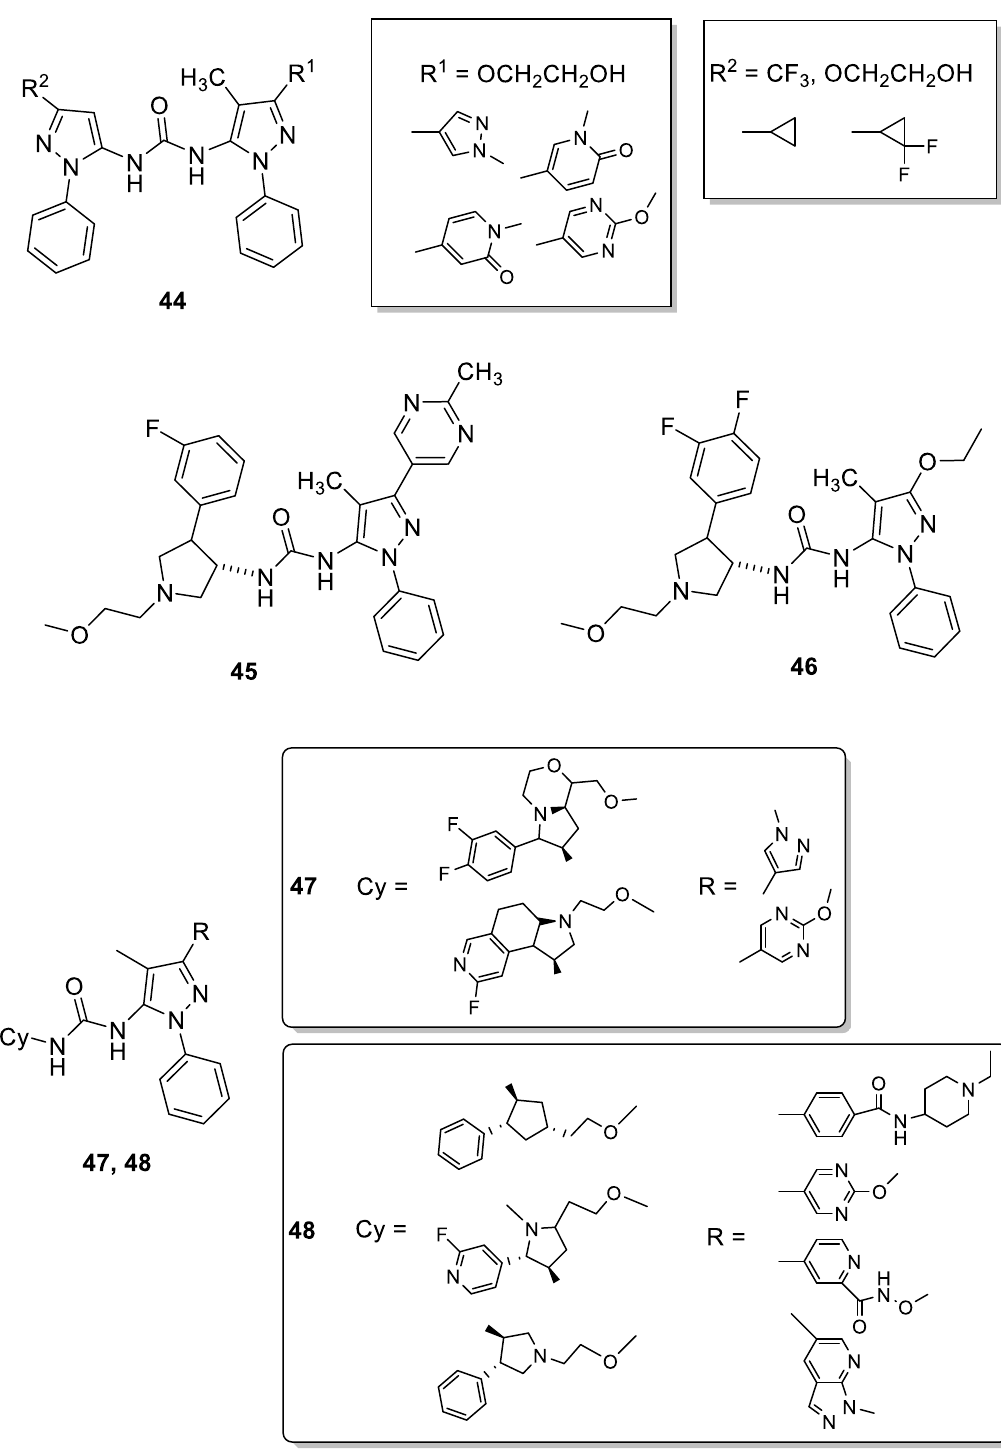
Figure 7. 5-Pyrazolyl-ureas reported as TrKA inhibitors.